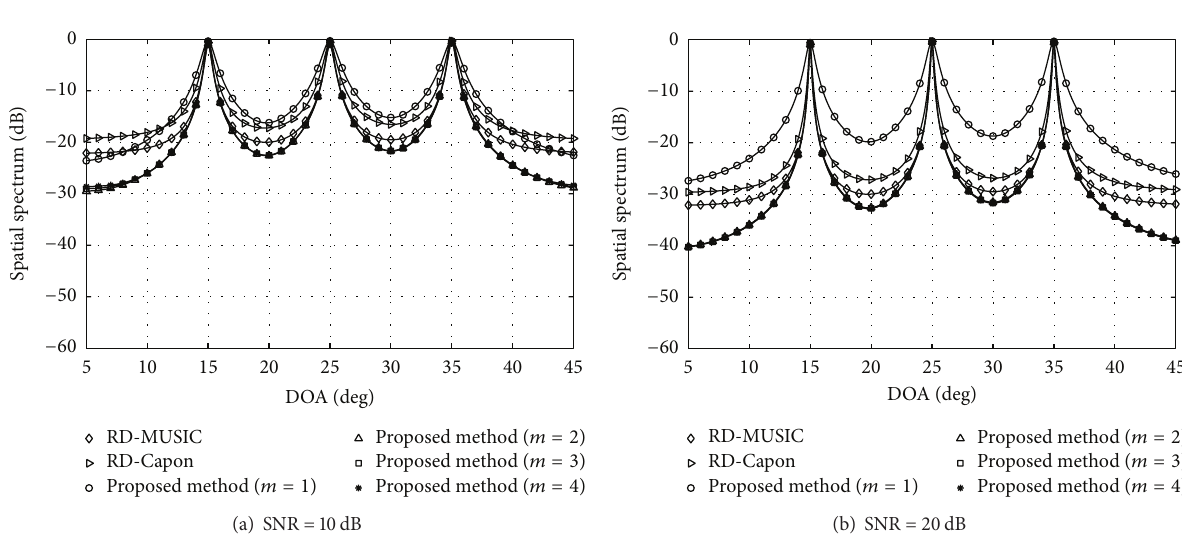
Figure 2: Spatial spectrum of DOA